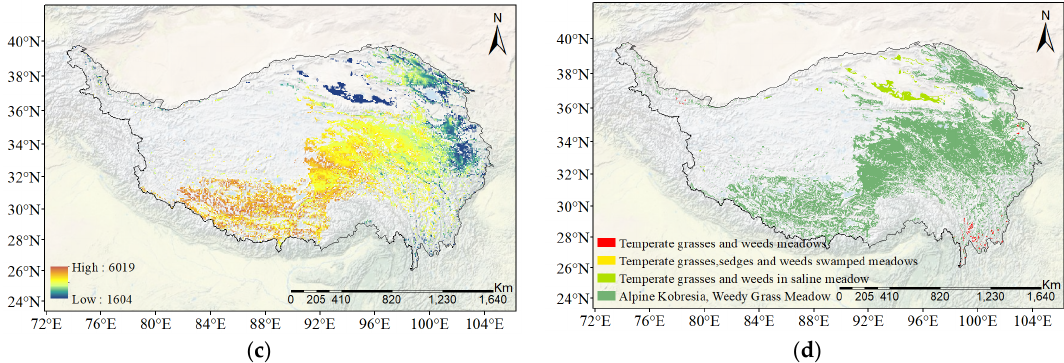
Figure 8. ( a ) Spatial distribution of seasonal temperature sensitivity of 𝑆𝐼𝐹𝑦𝑖𝑒𝑙𝑑 ; ( b ) spatial distribution of tau statistic in Mann–Kendall test. Dots indicate significance of regression or Mann–Kendall test ( p -value < 0.05). ( c ) Elevations of study region (data source: STRM-DEM); ( d ) spatial distribution of vegetation subtypes of Tibetan meadows (data source: vegetation map provided by the Institute of Botany, Chinese Academy of Sciences). Only regions recognized as meadows are displayed in these maps.